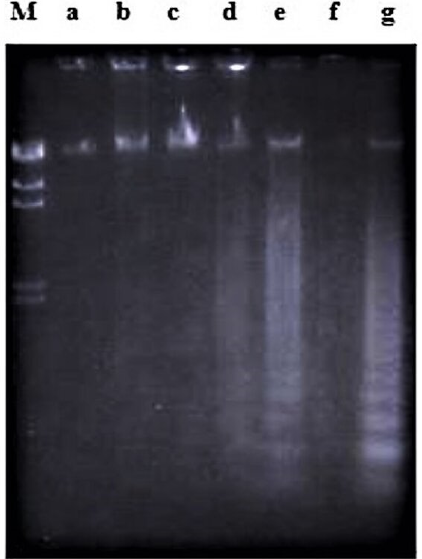
Figure 5. The involvement of RNA synthesis in nordamnacanthal-induced apoptosis in CEM-SS cells at 6 and 8 h. Actinomycin D failed to prevent apoptosis induced by 30 μg/mL of nordamnacanthal at 6 and 8 h. Lane a: control. Lane b: nordamnacanthal (30 μg/mL) (6 h- treatment). Lane c: actinomycin D (1 μg/mL) (6 h-treatment). Lane d: nordamnacanthal (30 μg/mL) + actinomycin D (1 μg/mL) (6 h-treatment). Lane e: nordamnacanthal (30 μg/mL) (8 h treatment). Lane f: actinomycin D (1 μg/mL) (8 h- treatment). Lane g: nordamnacanthal (30 μg/mL) + actinomycin D (1μg/mL) (8 h- treatment). Lane M: Marker (HindIII digest of lambda DNA).